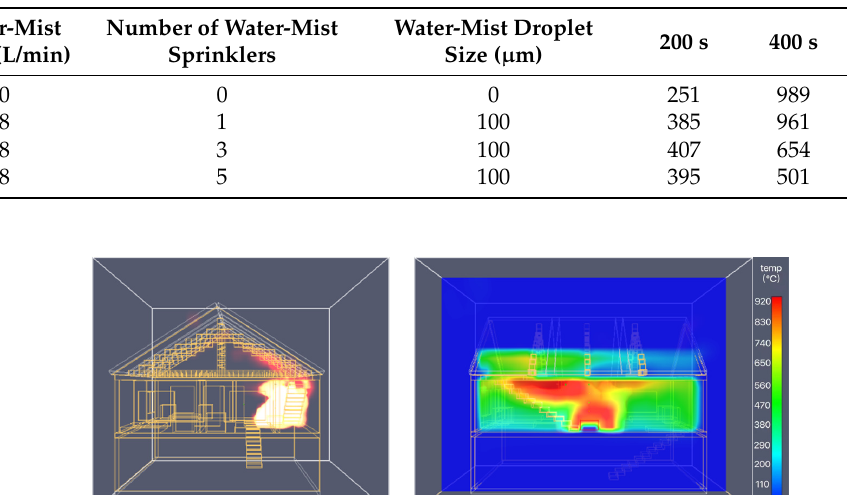
Table 6. Temperatures of different nozzle densities at 200, 400, 600s, and 800.